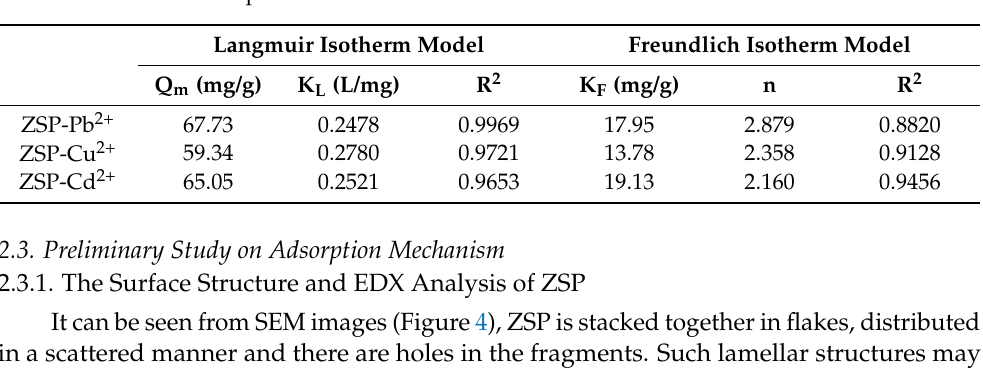
Table 2. Isotherm model